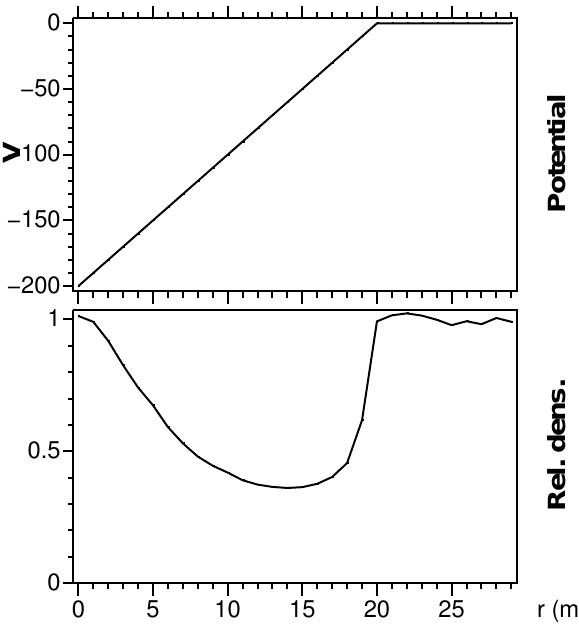
Fig. 11. Test particle calculation where 4000 electrons (tempera- ture 12 eV) were launched into a 20-m wide and 200V deep, linear- walled potential well (upper panel). Lower panels shows the result- ing electron